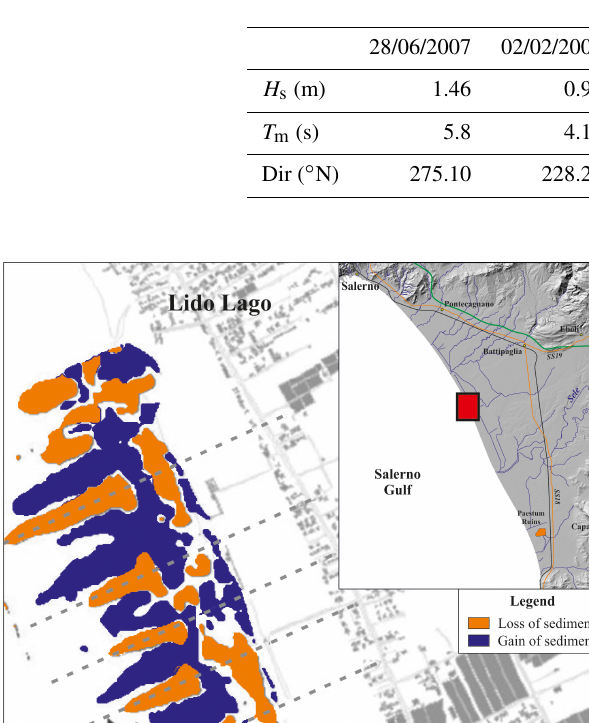
Table 2. Wave characteristics during numerical simulations and remote observations.